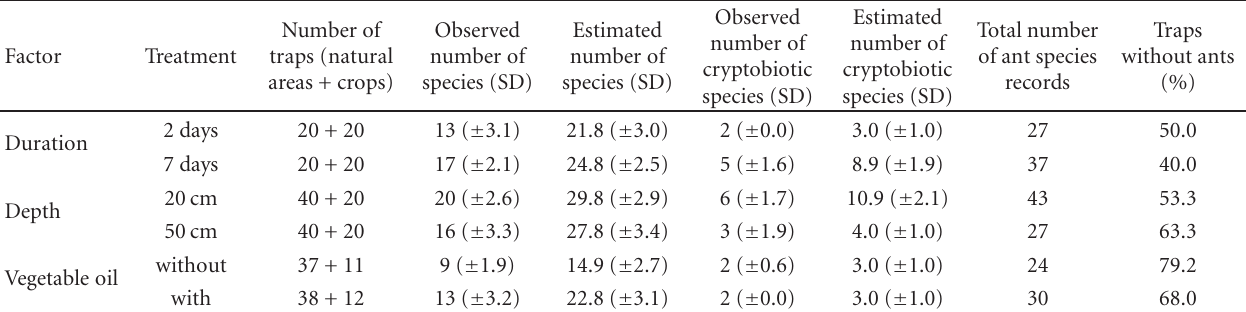
Table 1: E ffi ciency of the subterranean pitfall traps as a function of soil depth, time of trap exposure, and addition of vegetable oil on soil around